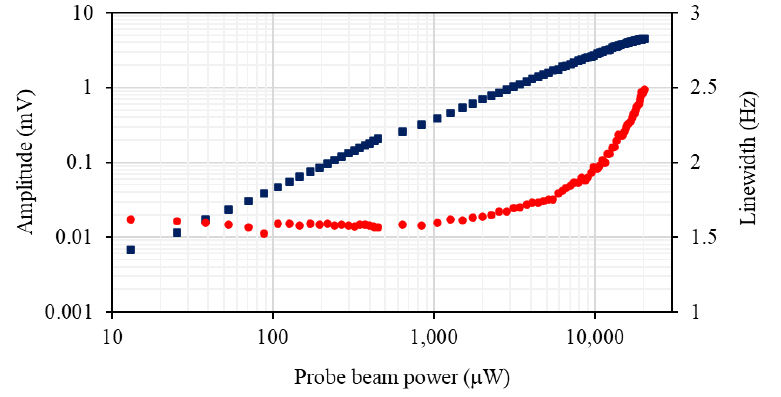
Figure 9. Amplitude (blue squares) and linewidth (red dots) of the rf spectral profile as a function of probe beam